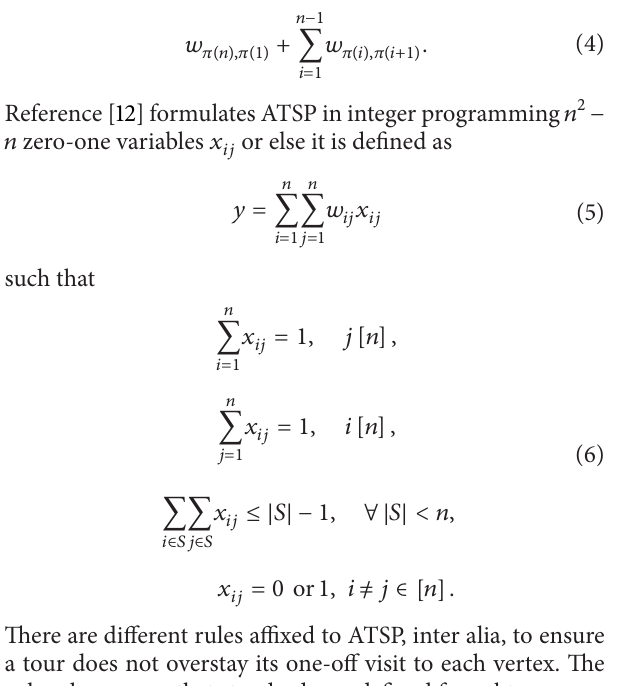
Figure 1: Nonstationary optima